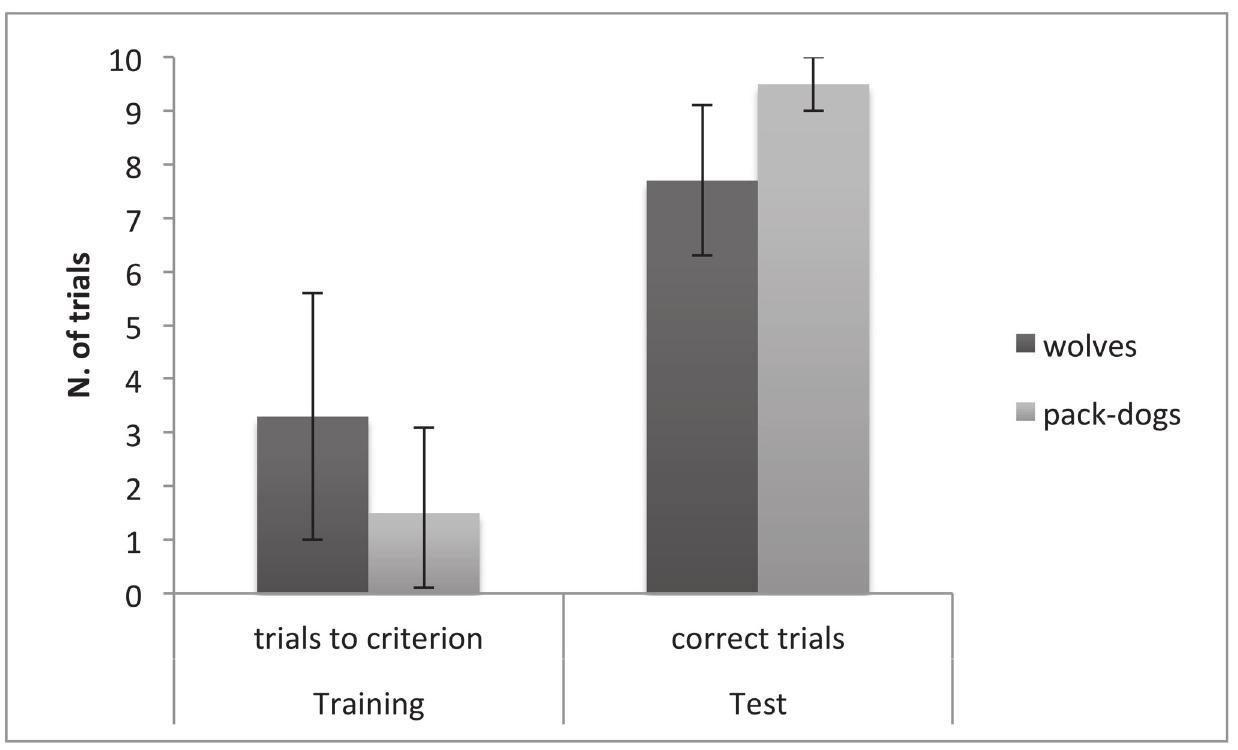
Fig 3. Wolves ’ and pack-dogs ’ performance in the cylinder task. Mean number (and 95% confidence interval) of trials to criterion in the training phase, and of correct trials in the test phase, for wolves and dogs in the cylinder task. * p < 0.01.